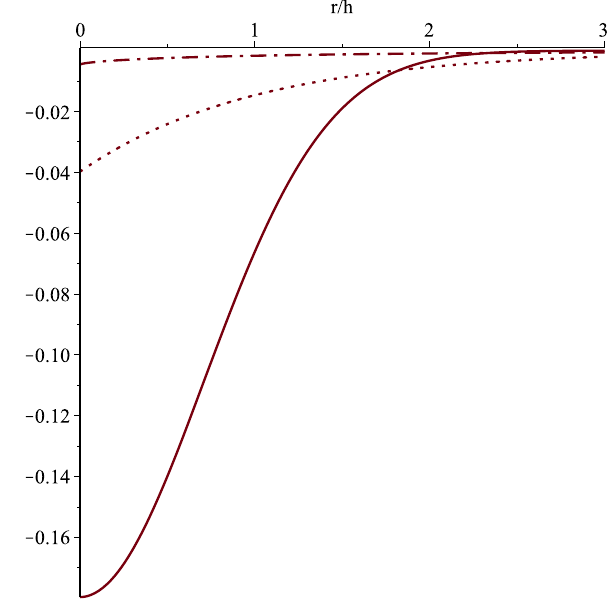
Fig. 1 Plot of h 3 p r / M given by (16) for ξ = 1 / 2 (solid line), ξ = 1 (dotted line) and ξ = 1 . 5 (dashdot line). In the DM case ( ξ = 7 . 072, h = 2 . 121 × 10 − 9 kpc and M = 4 . 57 × 10 9 M (cid:8) [29,30]) we have | p ( 0 ) | ≈ 5 . 8 × 10 − 41 m − 2 (geometricunits)orequivalently, | p r 7 × 10 3 N/m 2 (SI units)